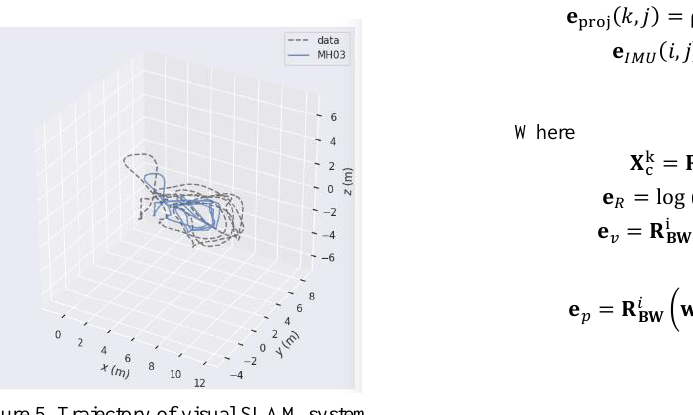
Figure 4. Complex environment